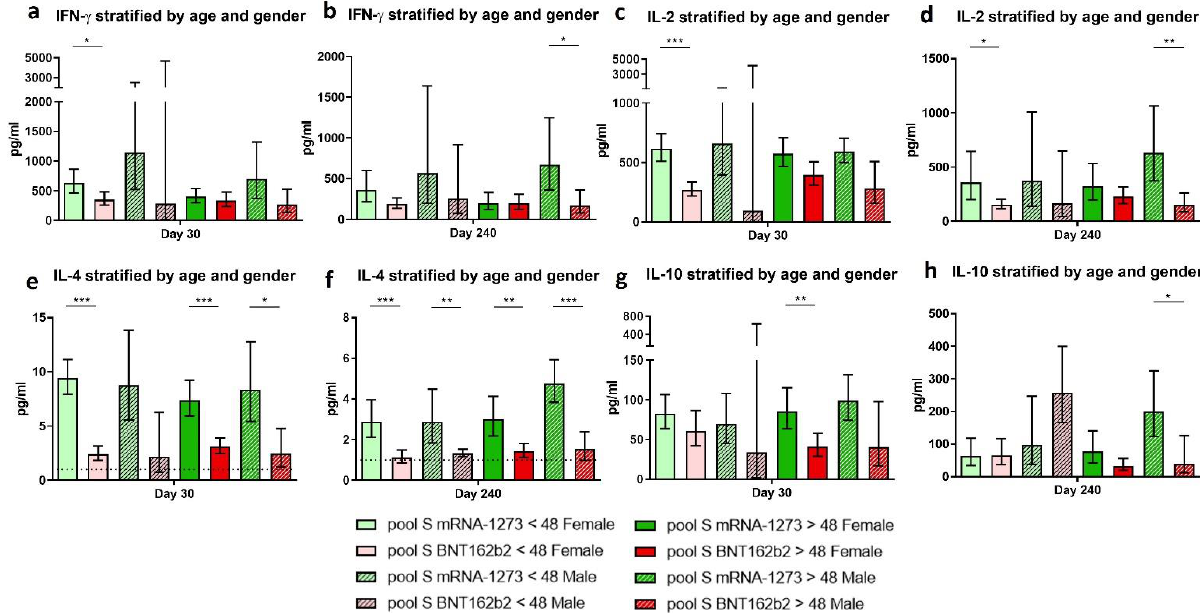
responses, independent of their age, when vaccinated with mRNA-1273 than with BNT162b2.